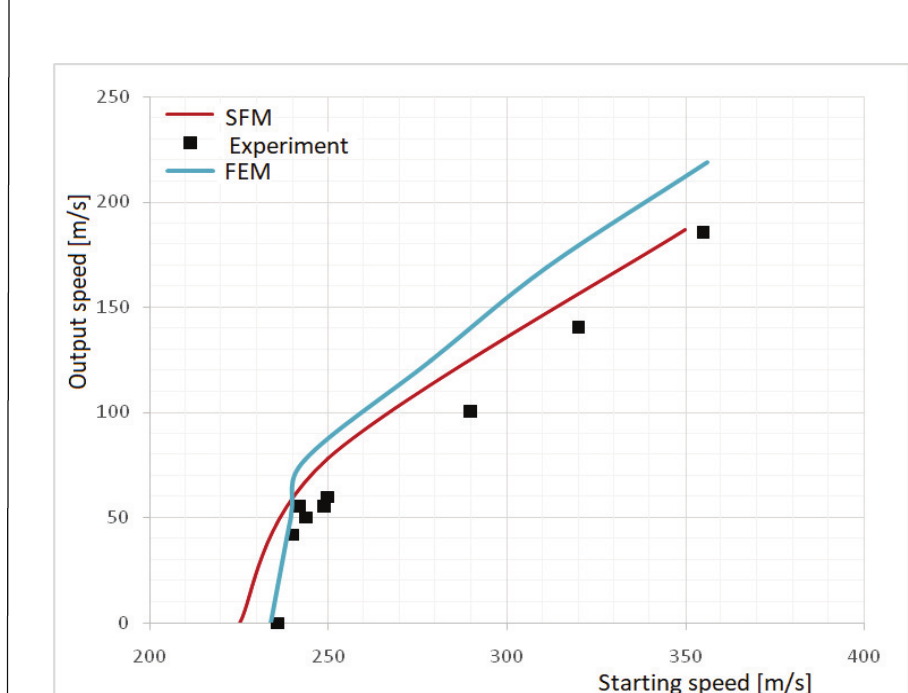
Figure 24 – Comparison of the results obtained by the FEM and SFM methods for a 16 mm thick steel plate with a blunt projectile Рис . 24 – Сравнительный анализ результатов , полученных FEM и